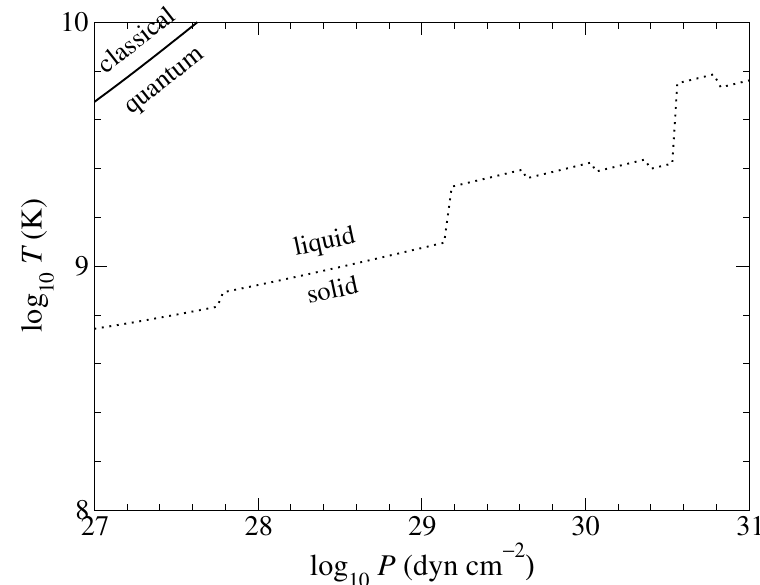
Figure 2. Same as Figure 1 for B (cid:63) = 3000 ( B ≈ 1.32 × 10 17 G). The magnetic field is strongly quantizing for all pressures and temperatures shown ( T B = 1.78 × 10 13